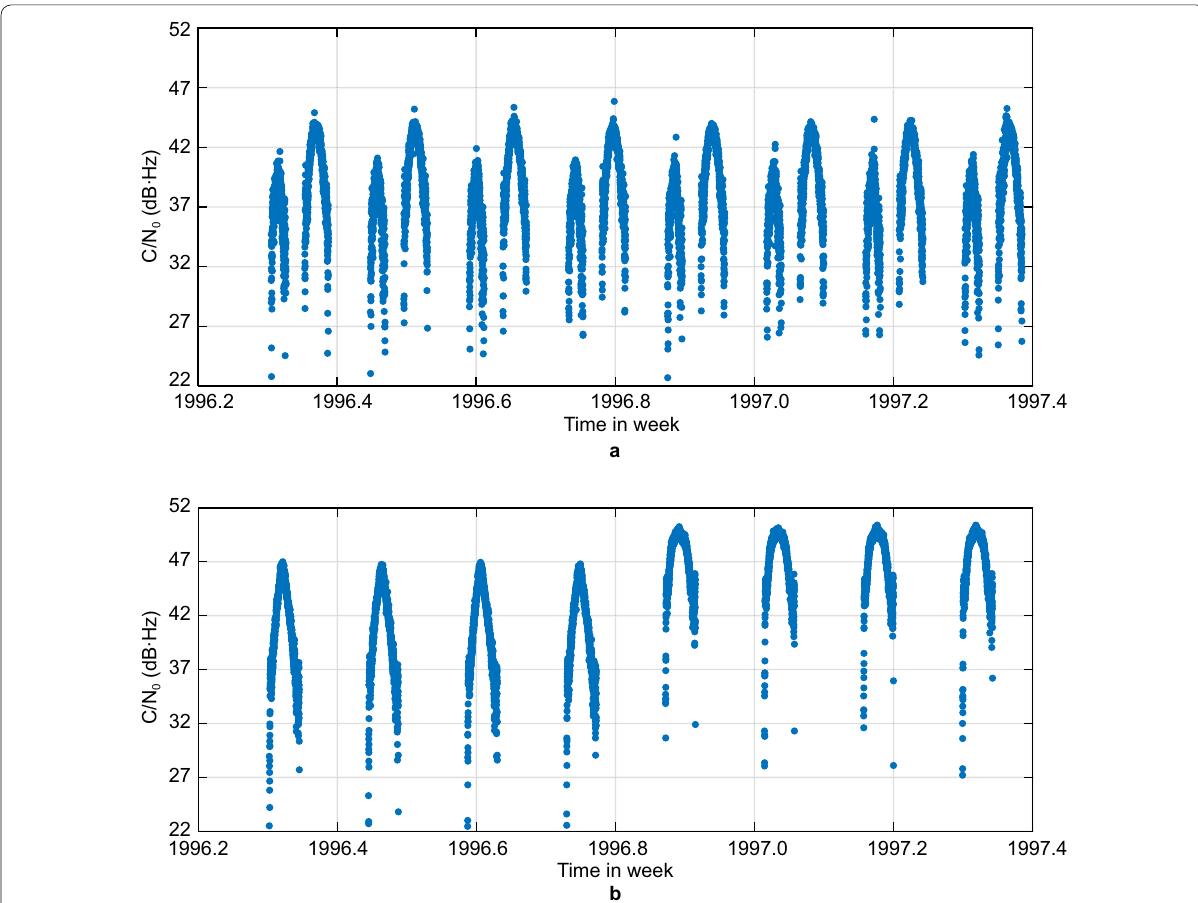
Fig. 4 The L2P(Y) signal C/N 0 observed at ANKR station in seven days; a PRN 2 satellite b PRN 7